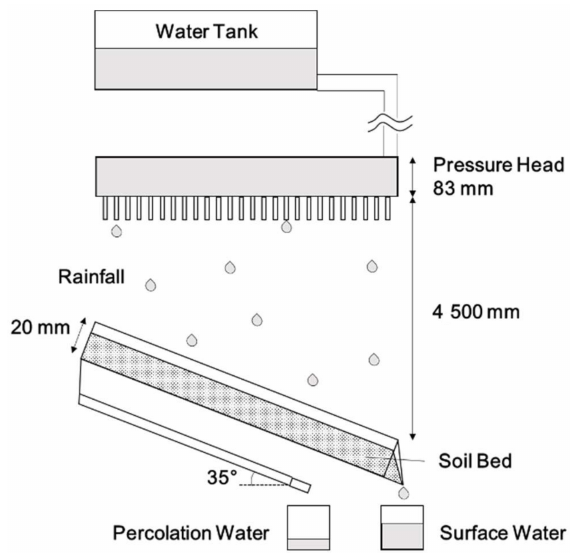
Figure 1. Schematic diagram of the artificial rainfall test